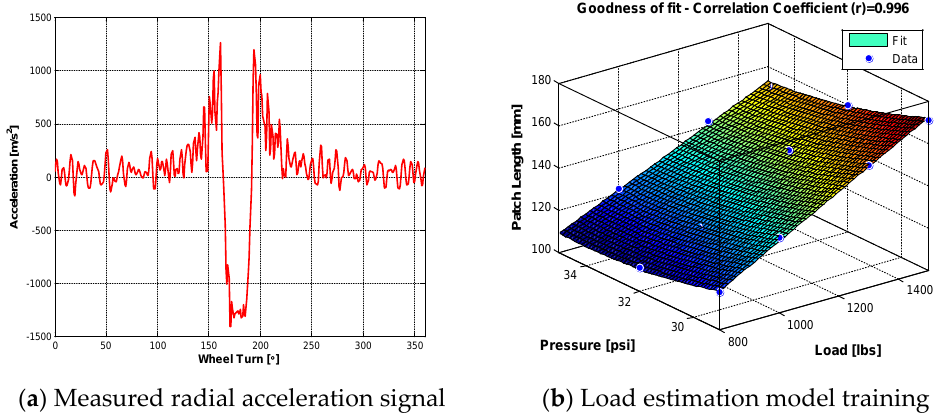
( b ) Load estimation model training Figure 7. Tire load estimation using a tire mounted accelerometer. Figure 7. Tire load estimation using a tire mounted accelerometer.